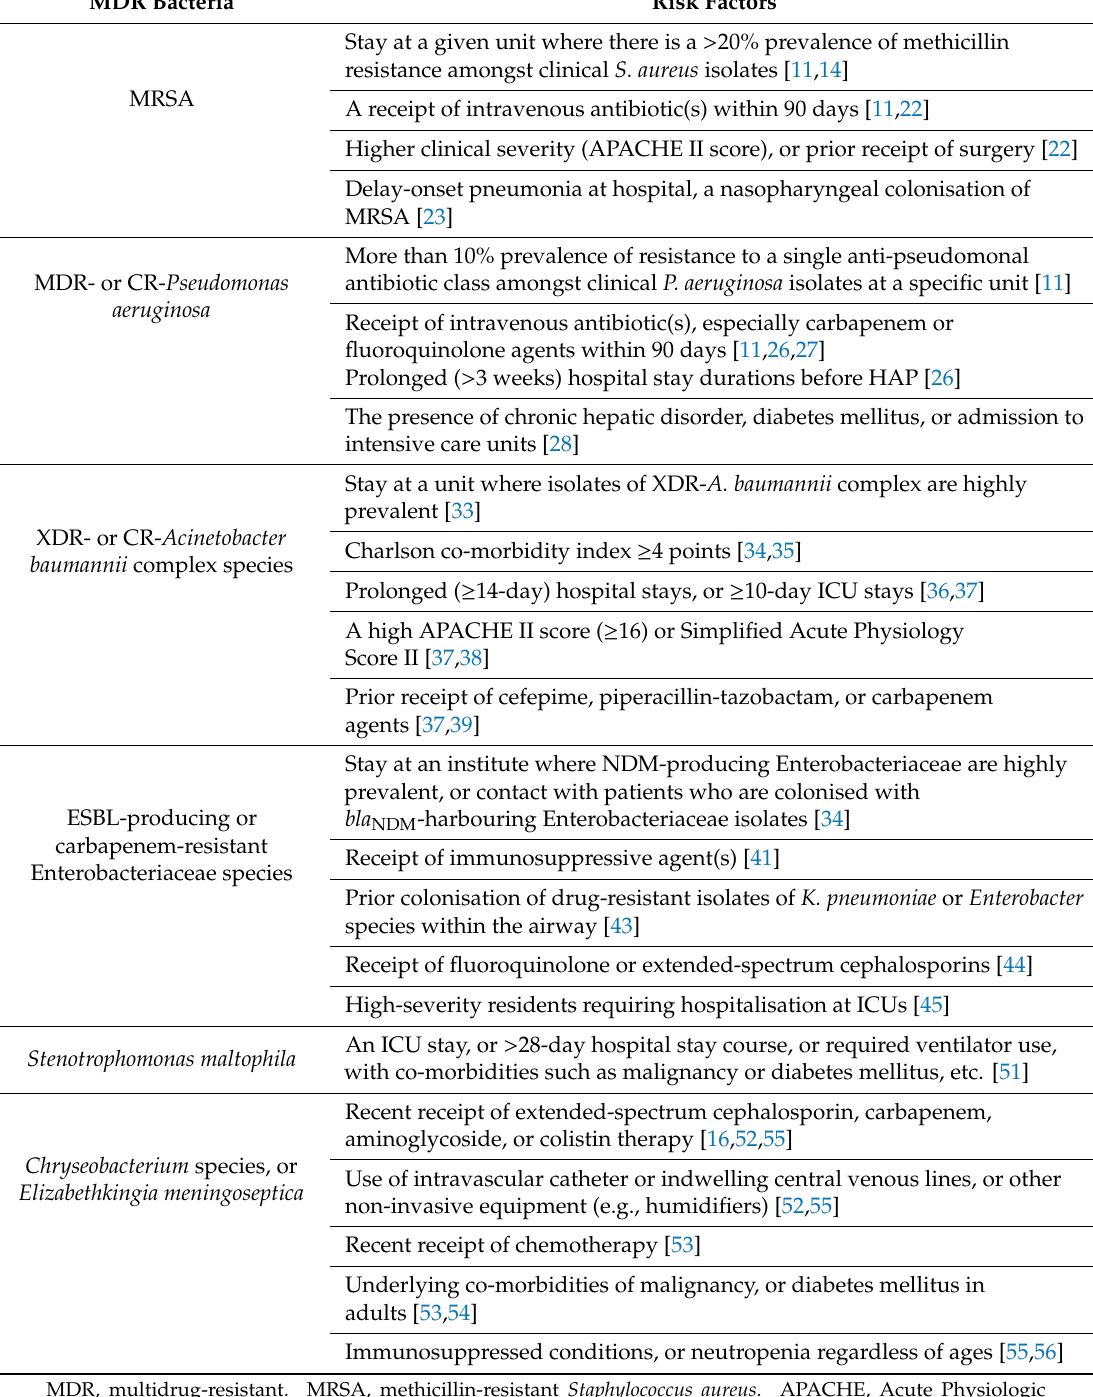
Table 1. The risk factors regarding acquisition of the following clinical multidrug-resistant bacteria. MDR